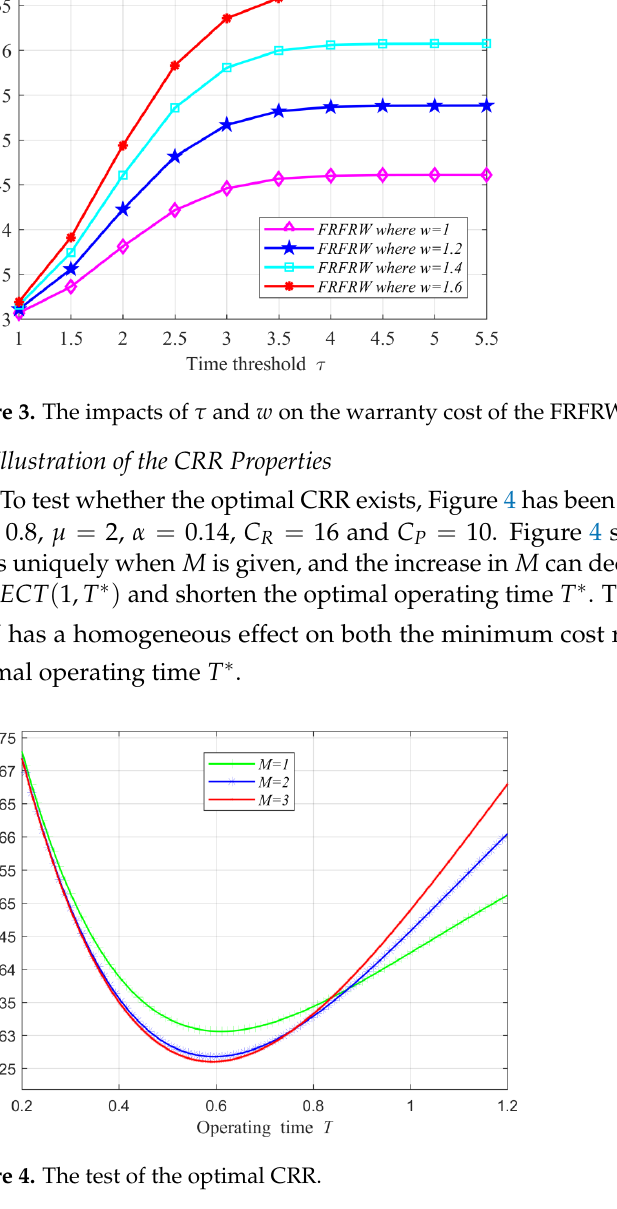
Table 1. The impacts of on the optimal CRR .